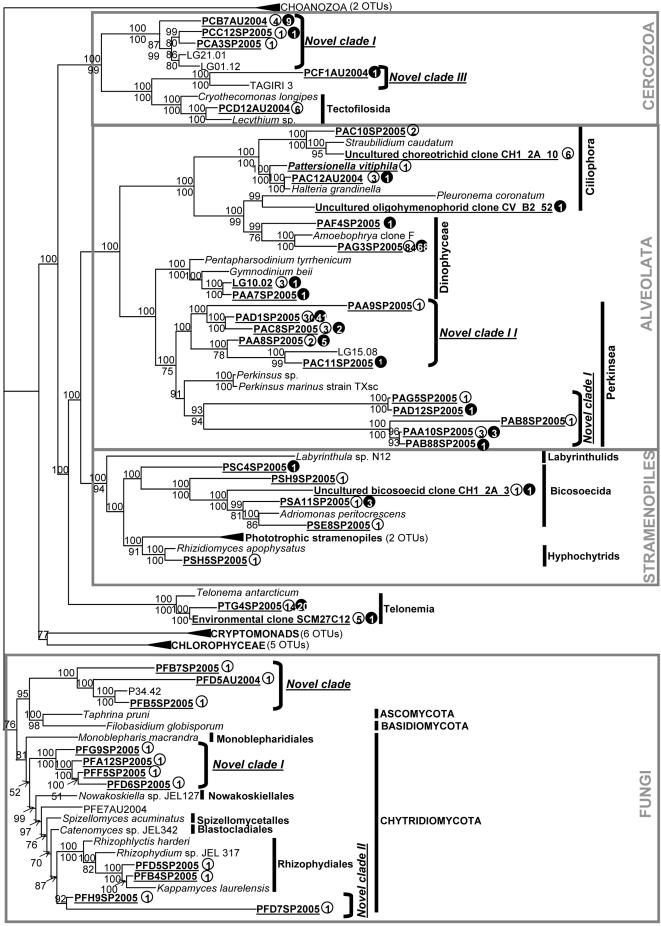
Bayesian phylogenetic tree of 18S rRNA gene obtained from the Lake Pavin.The Bayesian unrooted tree was inferred from an alignment of 88 sequences with a character sampling of 1511 nucleotides. The origin of phylotypes from lake Pavin and the number of clones are indicated after each of our underlined environmental sequences. A white circle symbol corresponds to the oxic zone and a black one to the oxycline. The numbers (given as percentages) above and below the nodes correspond to Bayesian Posterior Probabilities and bootstrap values calculated using the Neighbor-Joining method, respectively.